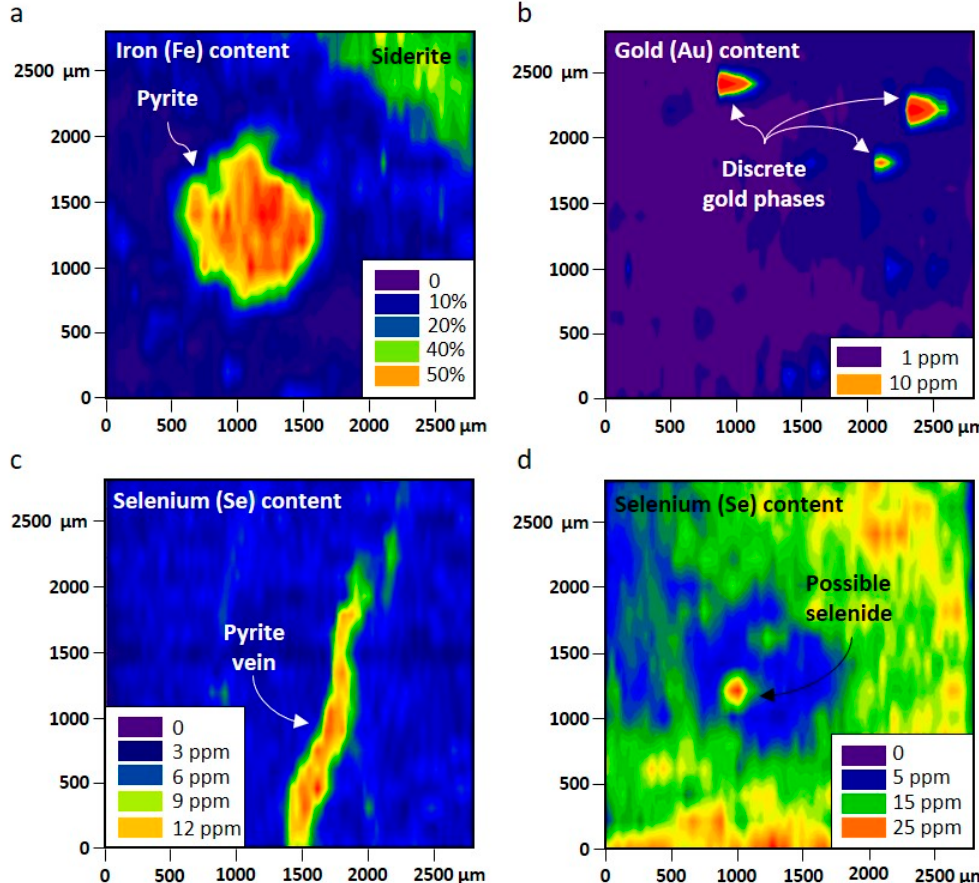
Figure 7. Laser ablation inductively coupled mass spectrometry (LA–ICP–MS) trace element maps of Castlecomer coal samples (CC6 and CC7). ( a ) High iron content indicating the presence of microscopic pyrite and siderite in coal (CC6). ( b ) Discrete gold phases (with silver absent) in association with pyrite and siderite (same area analysed as (a)). ( c ) Selenium concentrated within pyritic vein in coal (CC7). ( d ) Concentrated “hot spot” of selenium, indicating possible selenide within pyrite (CC6).